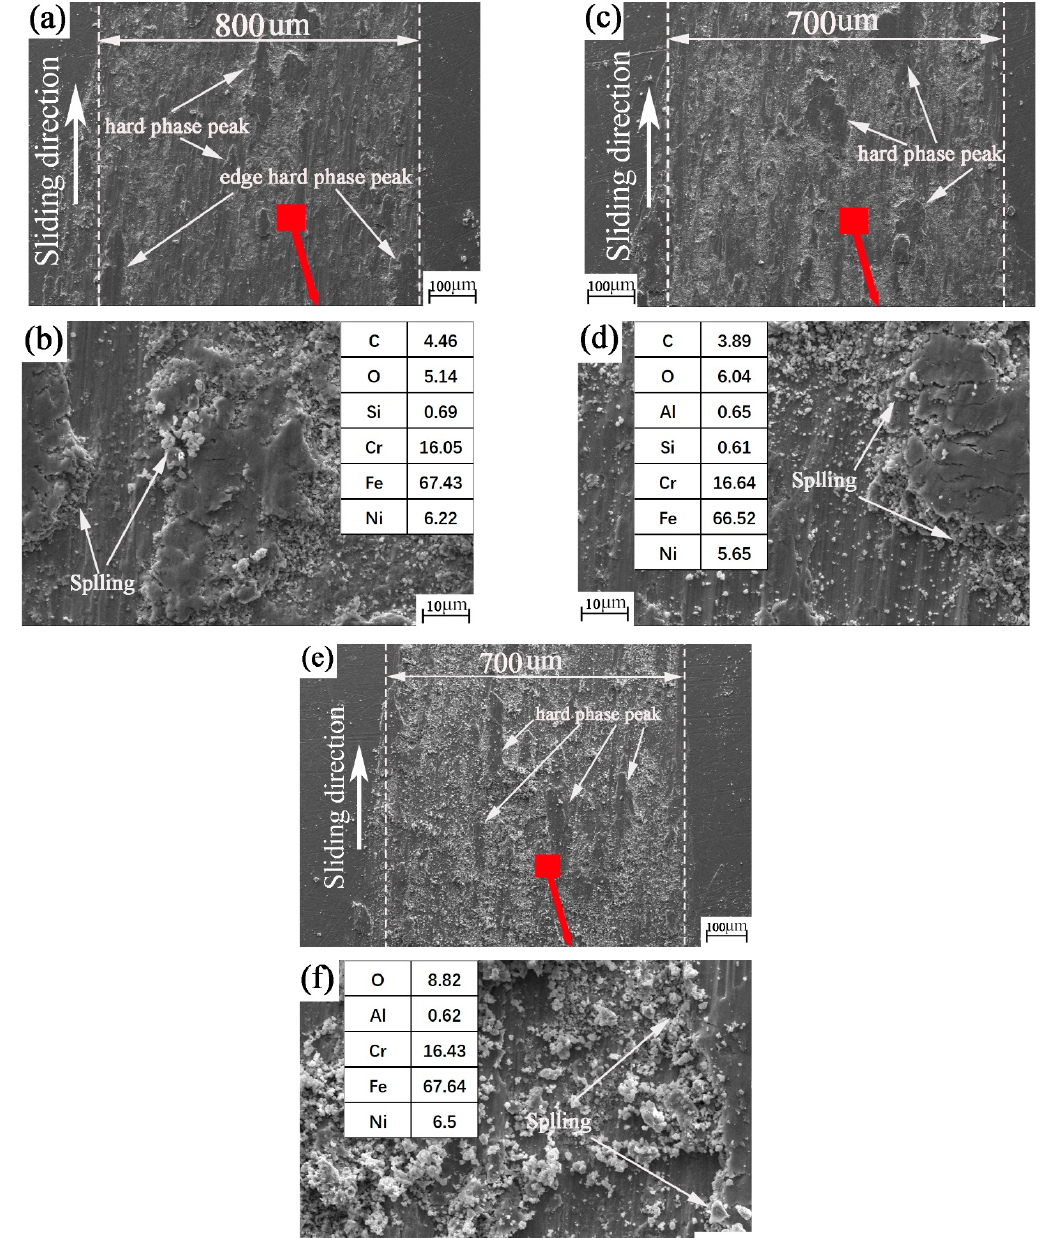
Figure 8. SEM and EDS images of the picosecond textured worn plates: ( a , b ) picosecond texture rotation radius 15 mm; ( c , d ) picosecond texture rotation radius 18 mm; ( e , f ) picosecond texture rotation radius 22.5 mm.